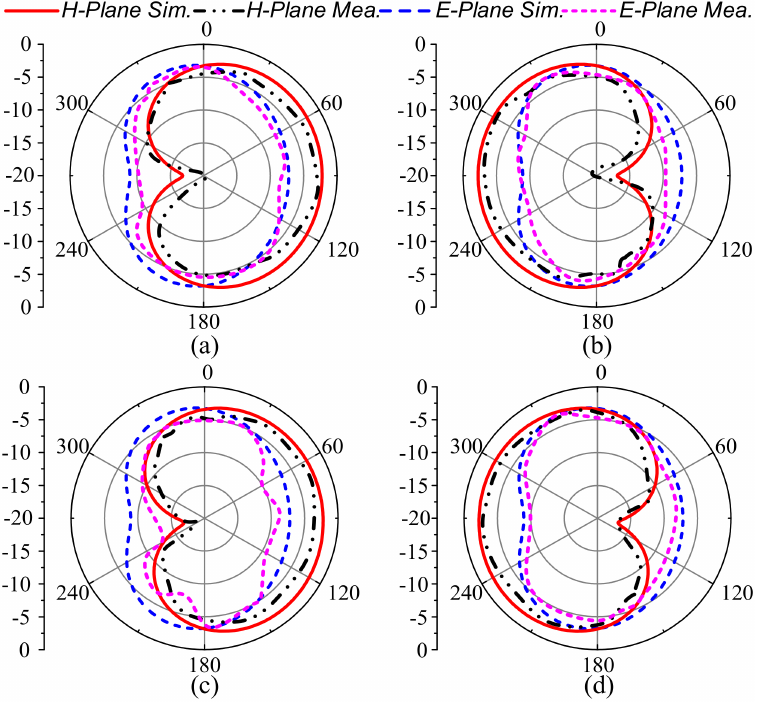
Figure 12. Comparison among simulated and measured radiation patterns of the antenna under bend condition at 2.1 GHz ( a ) bend along Y -axis [case-10], ( b ) bent along Y -axis, [case-01] ( c ) bent along X -axis [case-10], and ( d ) bent along X -axis